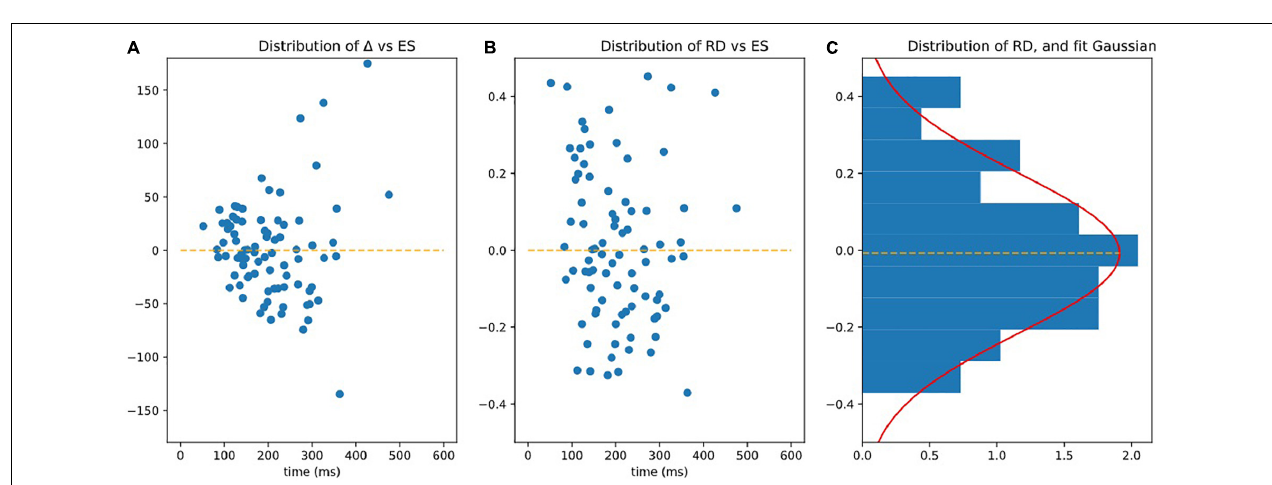
FIGURE 5 | Distributions of RRT and ET and ex-Gaussian fit.It is usual to fit reaction times with ex-Gaussian distribution. 3 ex-Gaussian parameters are considered: mu is the location (close to the center), sigma represents the width, and tau represents the length of the exponential tail. The quality of the fit is assessed by Kolmogorov-Smirnov test (KS), the smaller d (higher p ), the better fit. Here, the fit is extremely good. (A) Histogram of RRT and fit ex-Gaussian. (B) Histogram of ES and fit ex-Gaussian.